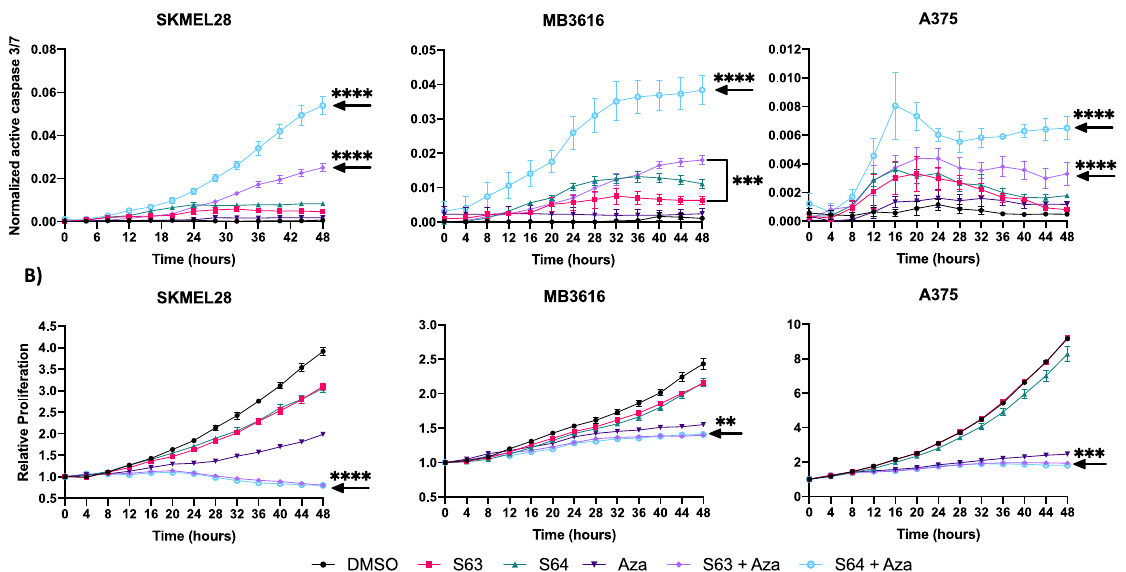
Figure 5. Treatment with S63845/S64315 plus AZA decreases proliferation and induces apoptosis. ( A ) IncuCyte live cell analysis of caspase 3/7 activity. Y axis indicates ratio of area expressing fluorescent signal. X axis indicates time in hours. ( B ) IncuCyte live cell analysis of cellular proliferation. Y axis represents confluence relative to 0 h. X axis indicates time in hours. For all graphs, error bars represent +/ − SEM. Arrow indicates lowest significance compared to all other conditions. ** indicates p < 0.01, ** indicates p < 0.001 **** indicates p < 0.0001.